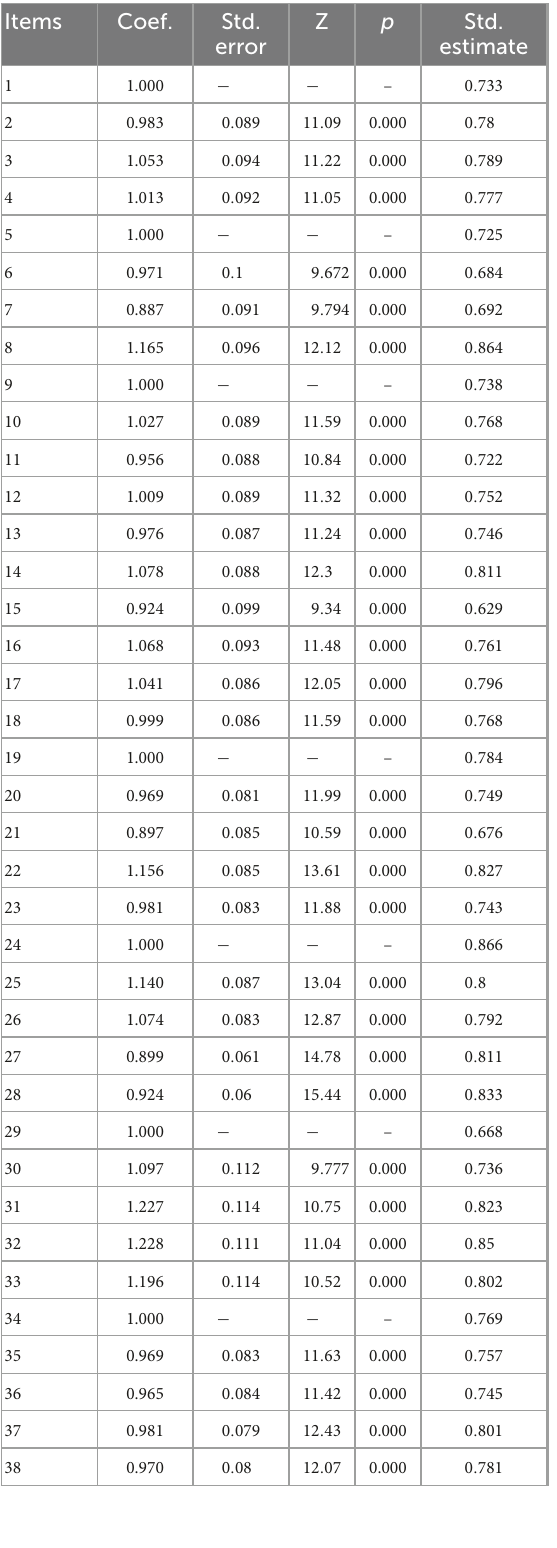
TABLE 4 The correlation between factors and analysis